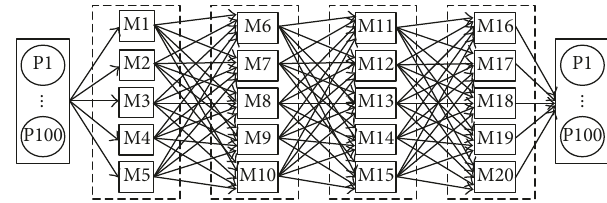
Figure 14: Job shop production with alternative part